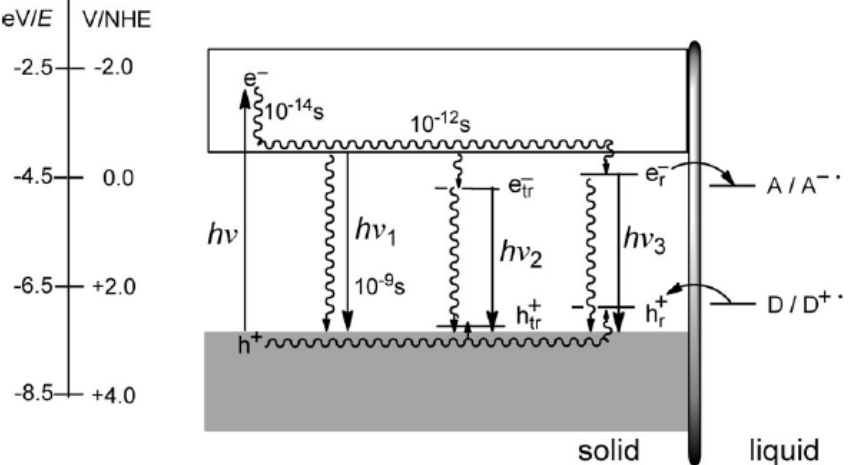
Figure 21. Schematic representation of the possible pathways that electrons and holes can follow after the irradiation of the semiconductor. Reprinted from [259] with permission from John Wiley and Sons.